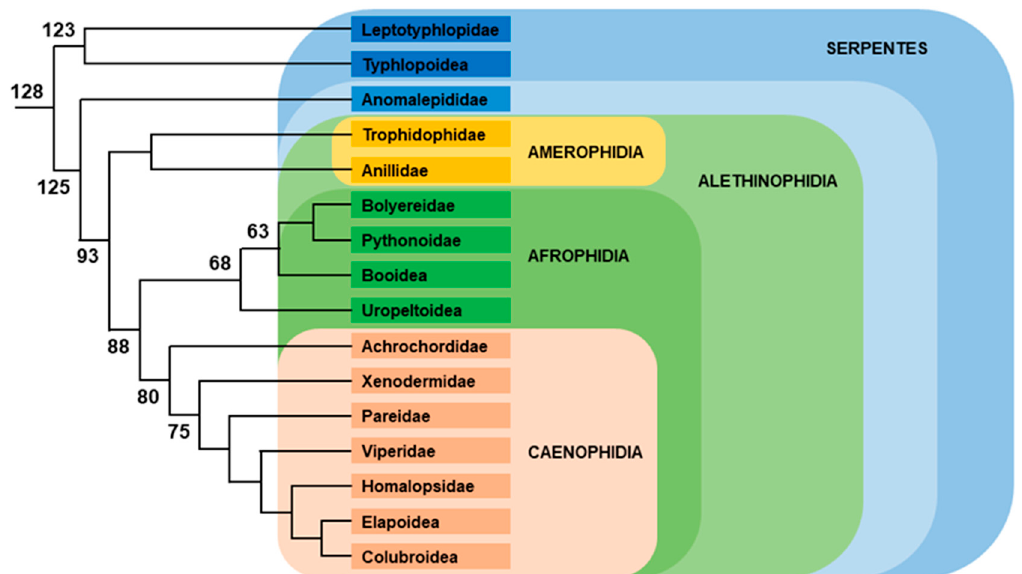
Figure 14. Phylogenic tree of snakes. Relative positions of each family and superior clade are represented. Branch lengths are not proportional to time. Numbers indicate divergence time (Myrs) from present for nodes, according to [38]. Colors indicate the different level of clades in the phylogenetic tree.